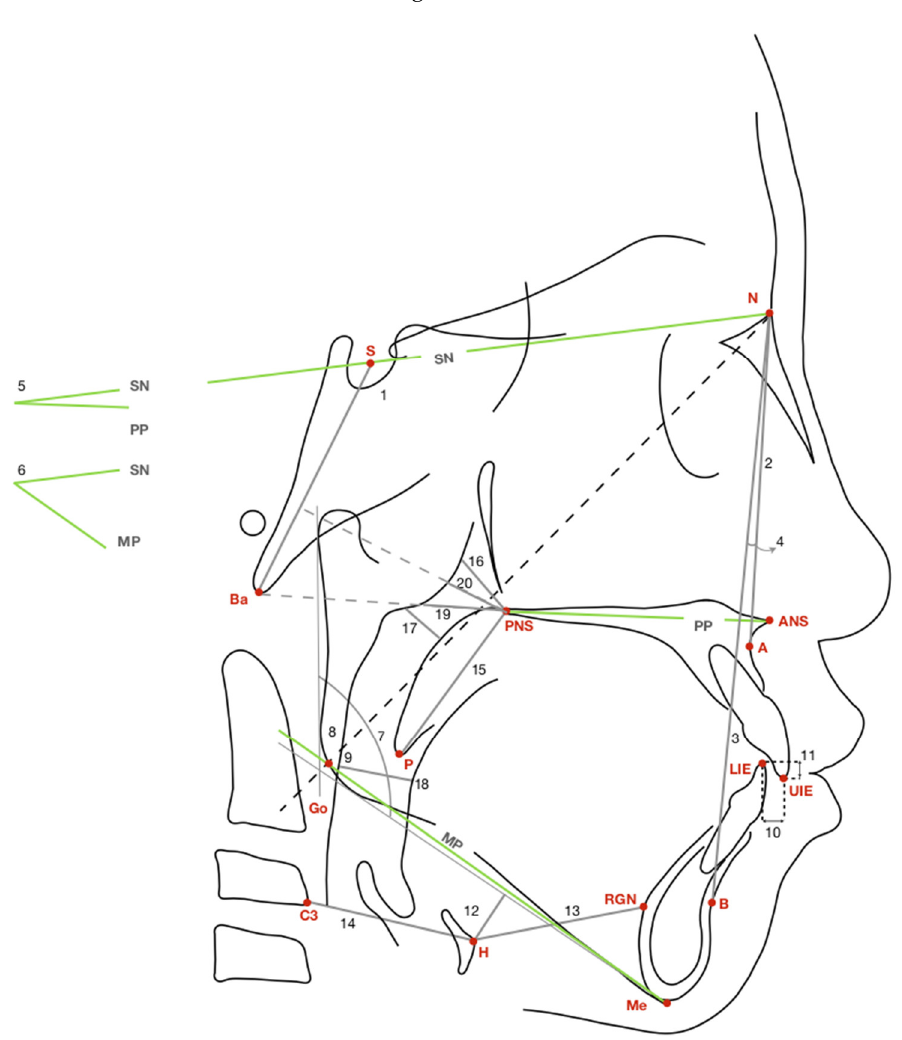
Figure 1. A diagrammatic representation of landmarks, reference lines, and variables used to identify the facial skeleton, teeth, upper airway, soft palate, tongue, and hyoid bone on a cephalometric radiograph. A: Subspinale. ANS: Anterior nasal spine. B: Supramentale. Ba: Basion. C3: Most anteroinferior point of third cervical vertebral body. Go: Gonion. H: Most anterosuperior point of hyoid bone. LIE: Lower incisor edge. Me: Menton, the most inferior point on symphyseal outline. MP: Mandibular plane, plane constructed from Me through Go. N: Nasion. P: Most inferior tip of soft palate. PNS: Posterior nasal spine. PP: Palatal plane, plane constructed from ANS through PNS. RGN: Retrognathion. S: Sella. SN: Line from sella to nasion. UIE: Upper incisor edge. 1. SNBa; 2. SNA; 3. SNB; 4. ANB; 5. SNPP; 6. SNMP; 7. Gonial angle; 8. Upper gonial angle; 9. Lower gonial angle; 10. Overjet; 11. Overbite; 12. MP-H; 13. H-RGN; 14. Hy-C3; 15. LSP; 16. PNSNPhp; 17. MinRPA; 18. MinRGA; 19. PNSAD1; and 20. PNSAD2.